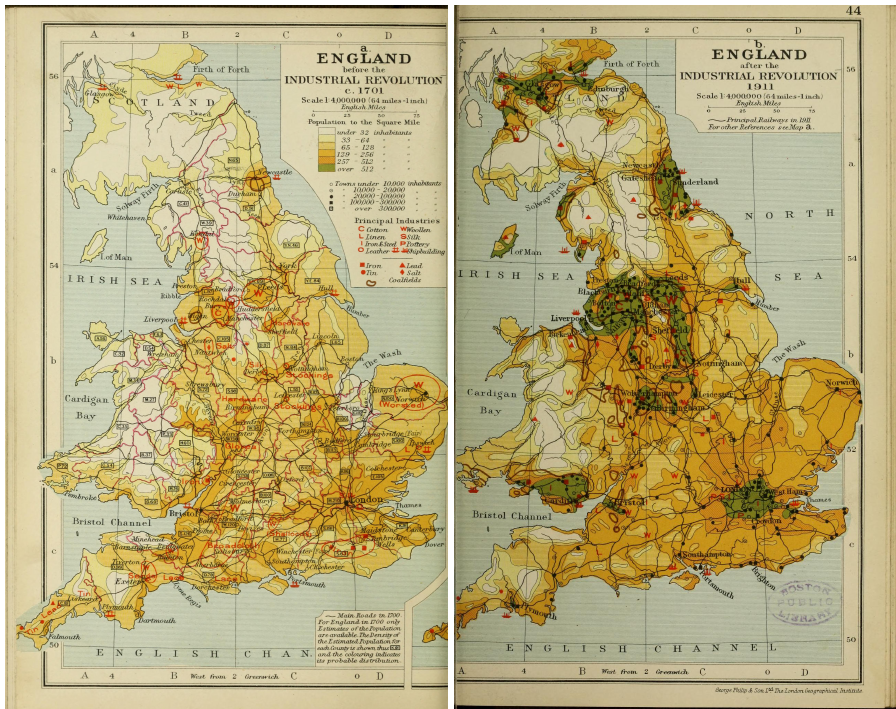
Figure 1. Urbanisation in the Industrial Revolution: During the Industrial Revolution, population density increased in industrial hubs. As such, population density accurately depicts locations of industry. (Source: Map courtesy of Philip’s, a division of Octopus Publishing Group, originally featured in Philip’s New Historical Atlas for Students,